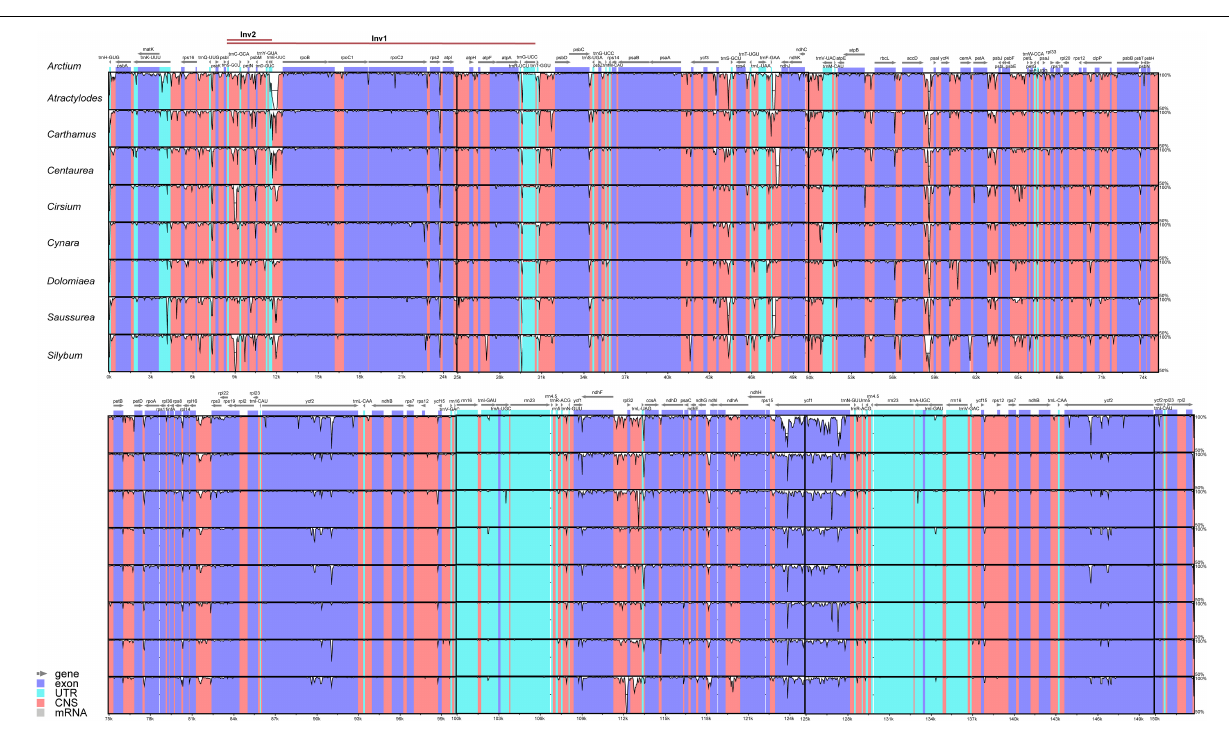
FIGURE 3 | Visualization of the alignments of nine plastomes representing nine genera of Cardueae using mVISTA, with Arctium lappa as the reference. The gray arrows above the alignment indicate genes. Different colors represent different regions (coding and non-coding). The horizontal axis indicates the coordinates within the chloroplast genome. The vertical scale represents the percentage of identity, ranging from 50% to